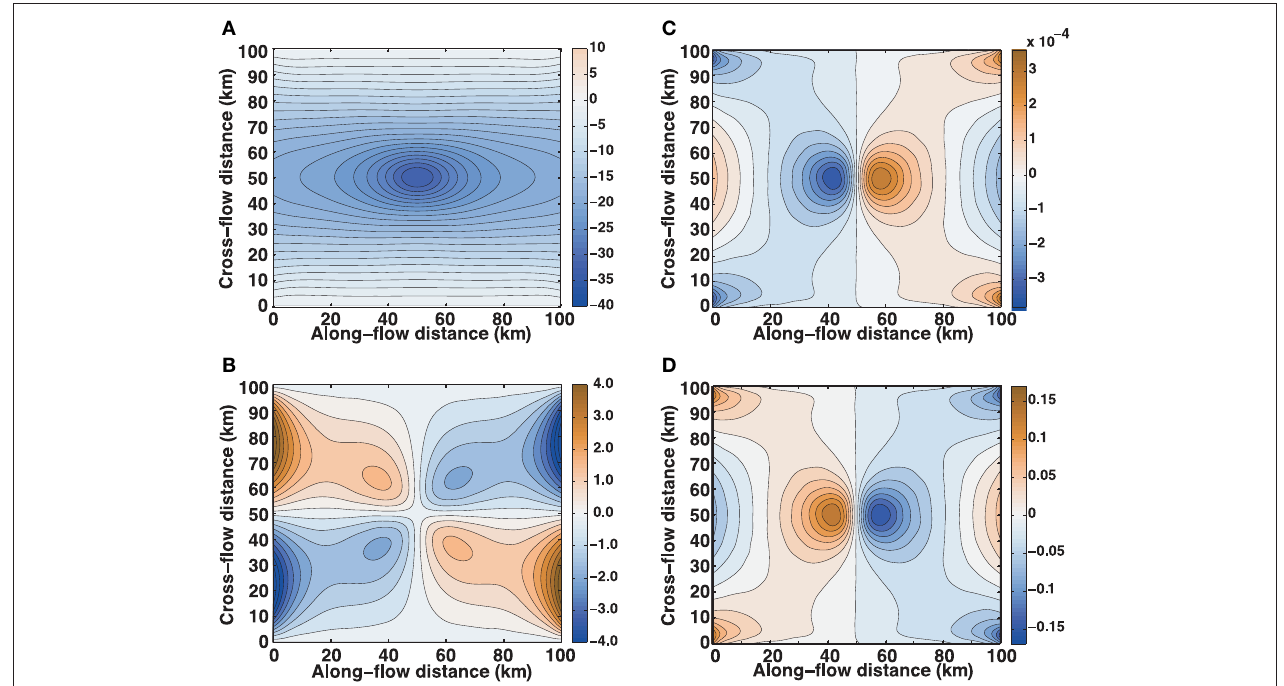
FIGURE 7 | (A–C) Viscous components of (A) along-flow velocity perturbation (m a − 1 ), (B) cross-flow velocity perturbation (m a − 1 ), and (C) two-dimensional divergence of velocity perturbation (s − 1 ), all at t = 12 h, for the η = 10 14 Pa s experiment; (D) Time-averaged thickening rate (m a − 1 ) resulting from viscous component of perturbation. Mean velocity is from left to right in the positive along-flow direction.